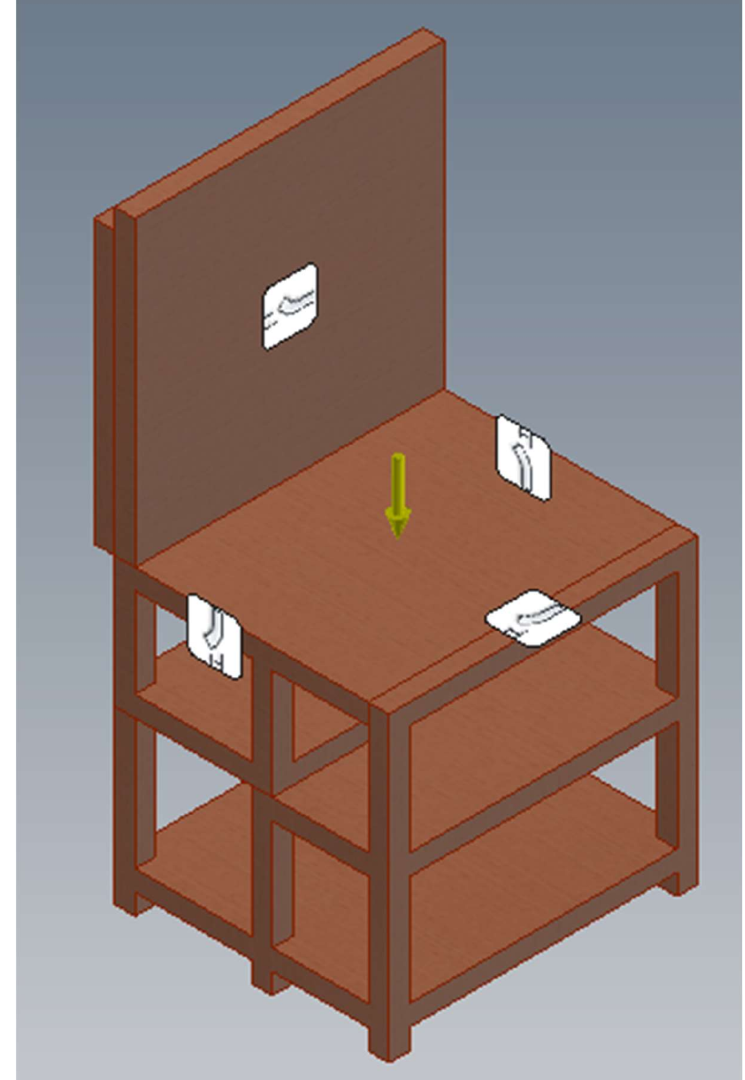
Figure 8. Overview of force applied on